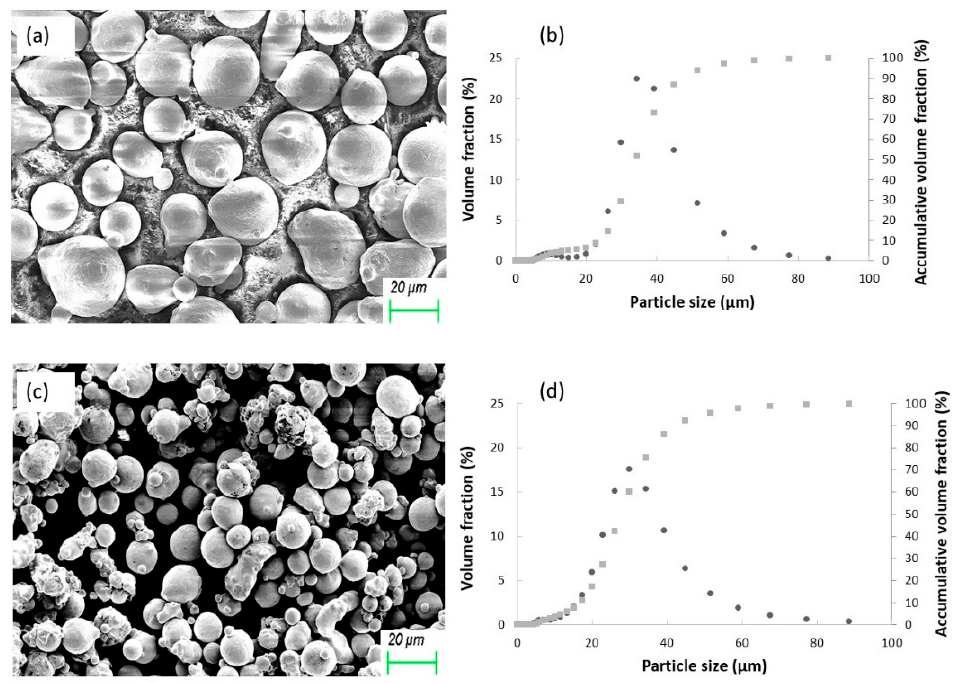
Figure 1. ( a ) Morphology and ( b ) size distribution of IN718 particle; ( c ) morphology and ( d ) size distribution of nickel particle.